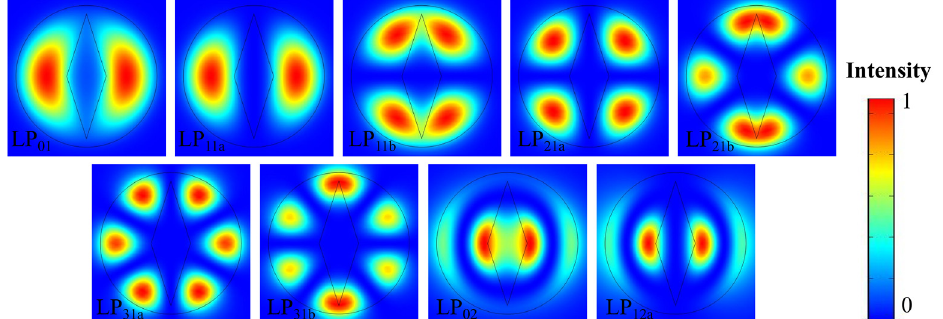
Figure 3. Normalized mode distribution of diamond − assisted ring − core fiber (color in this figure represents the intensity of the normalized mode distribution).